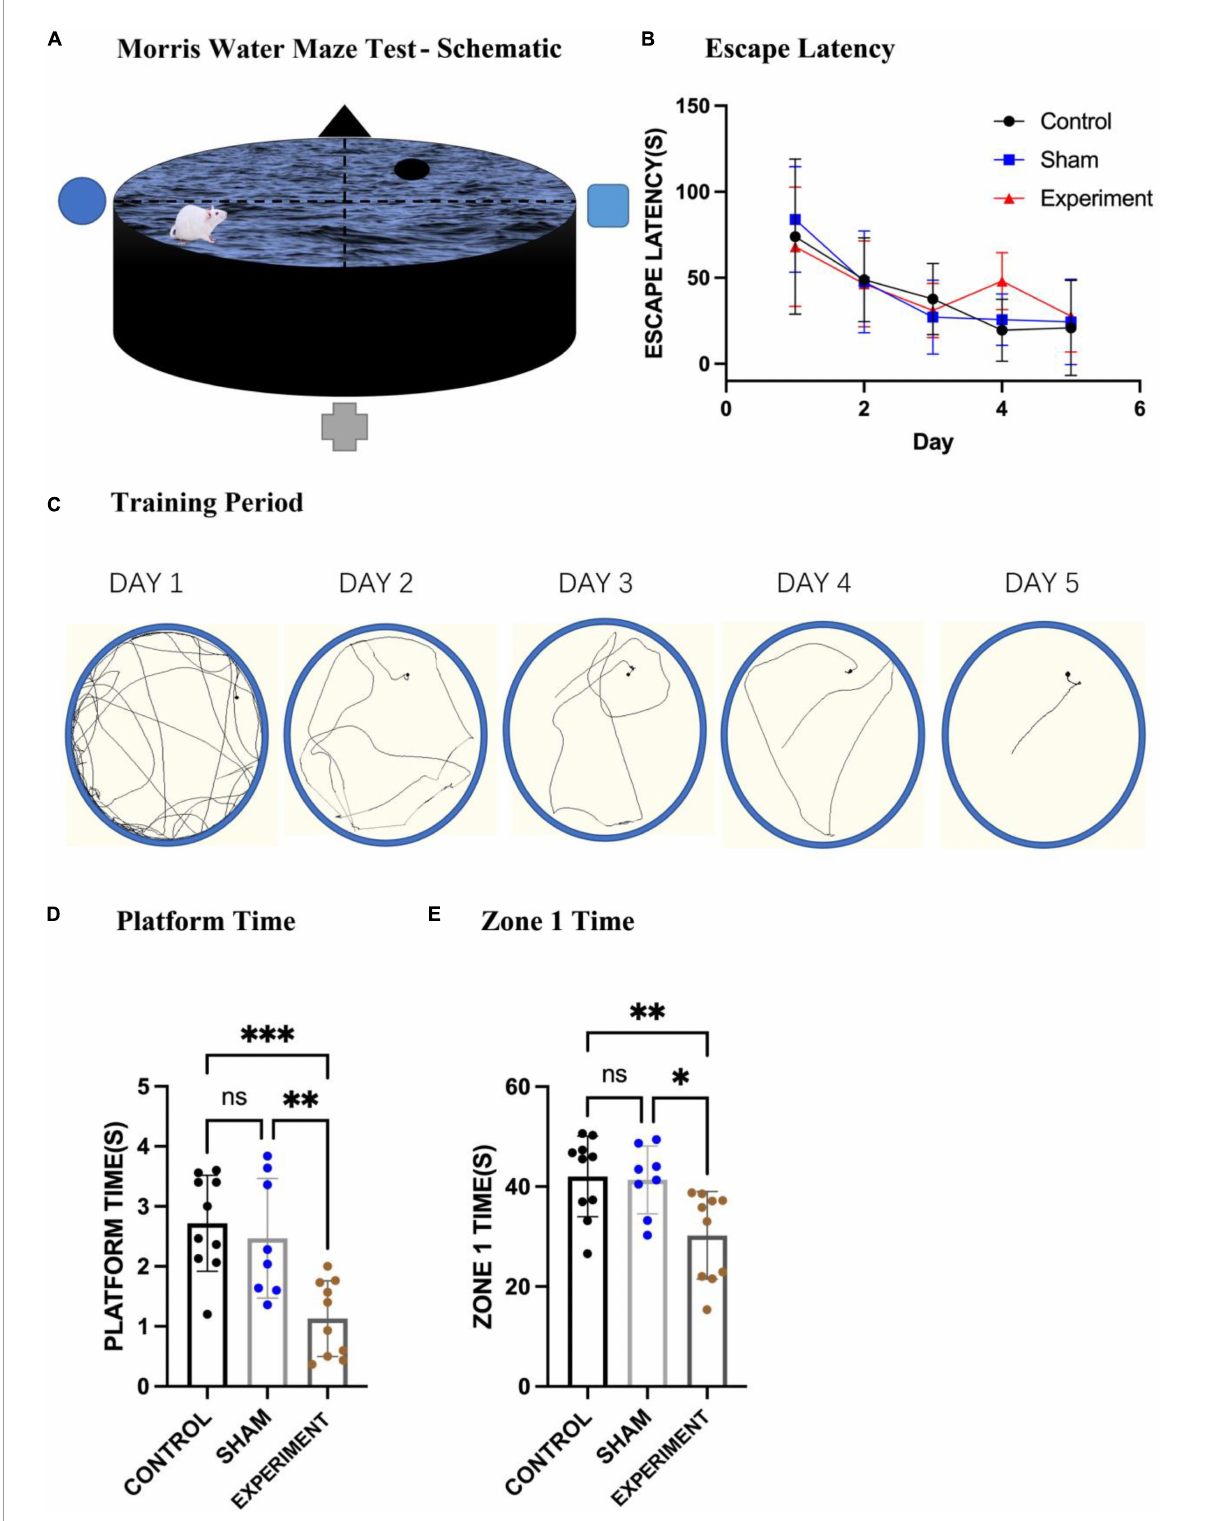
FIGURE5 Morris water maze test. (A) A schematic of the MWM apparatus. (B) The mean times of the three groups swimming to the platform (mean ± SD). (C) Changes in locomotion trajectories of the rats reaching to the platform during the 5-day training period. (D) The times spent in the original platform area after the platform was removed (mean ± SD). (E) The times stayed in zone 1 on the sixth day of the test (mean ± SD). ∗ p < 0.05, ∗∗ p < 0.01, ∗∗∗ p <